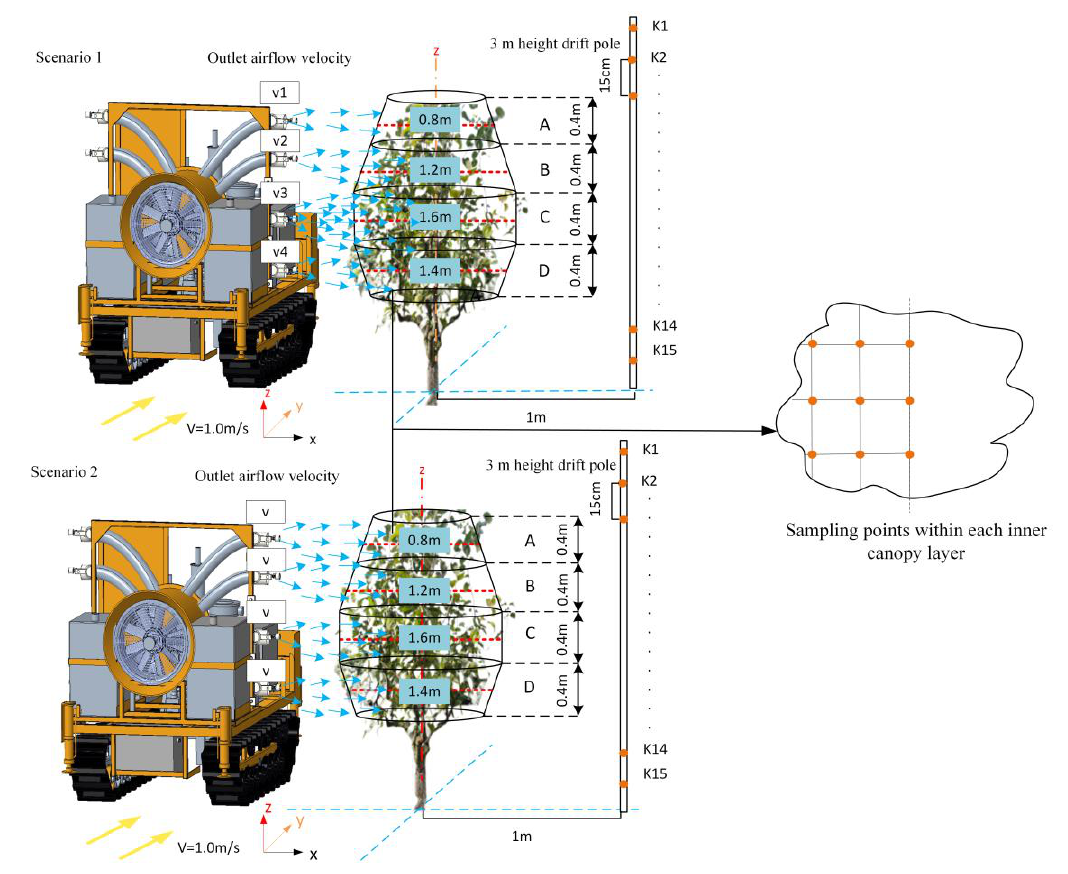
Figure 4. Validation field trials. Scenario 1: the four airflow outlets were set to different airflow velocities, which satisfy the ICAEV. Scenario 2: the four air outlets were set to the same airflow velocity.